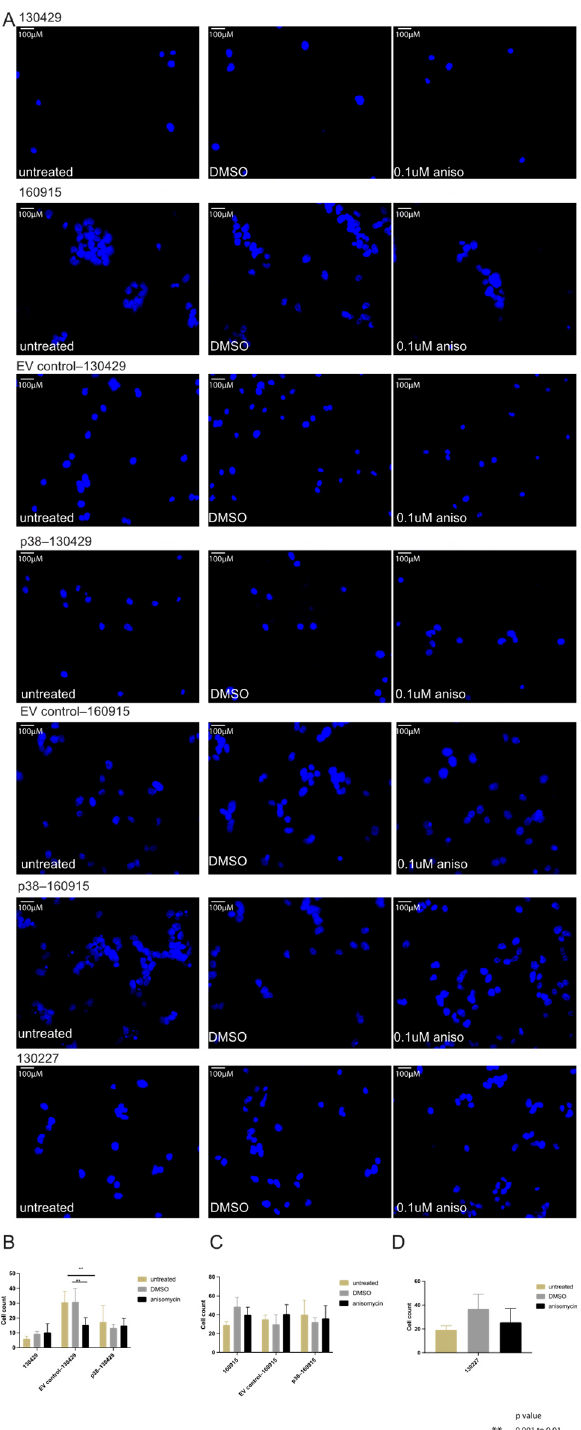
Figure 5. ( A ): Immunofluorescence staining of nucleus (blue) in cell lines 130429, 160915, 130227, EV control–130429/160915, and p38–130429/160915 under DMSO and 0.1 µ M anisomycin for 24 h. ( B ): Cell counts from immunofluorescence staining of nucleus in cell type 130429, EV control–130429, and p38–130429 under varying treatment conditions. Significant difference observed in anisomycin- treated cells compared with DMSO-treated ( p = 0.0034) and untreated cells ( p = 0.004). ( C ): Cell counts from immunofluorescence staining of nucleus in 160915, EV control–160915, and p38–160915 under varying treatment conditions. ( D ): Cell counts from immunofluorescence staining of the nucleus in cell line 130227 under varying treatment